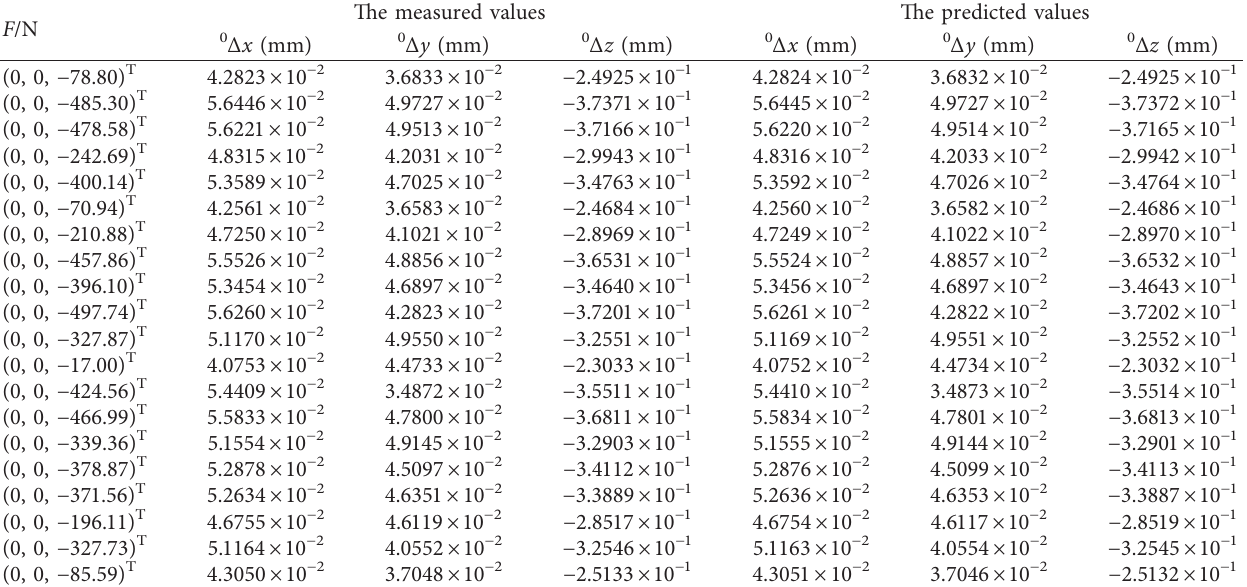
Table 5: The data for model verification. The measured values The predicted values